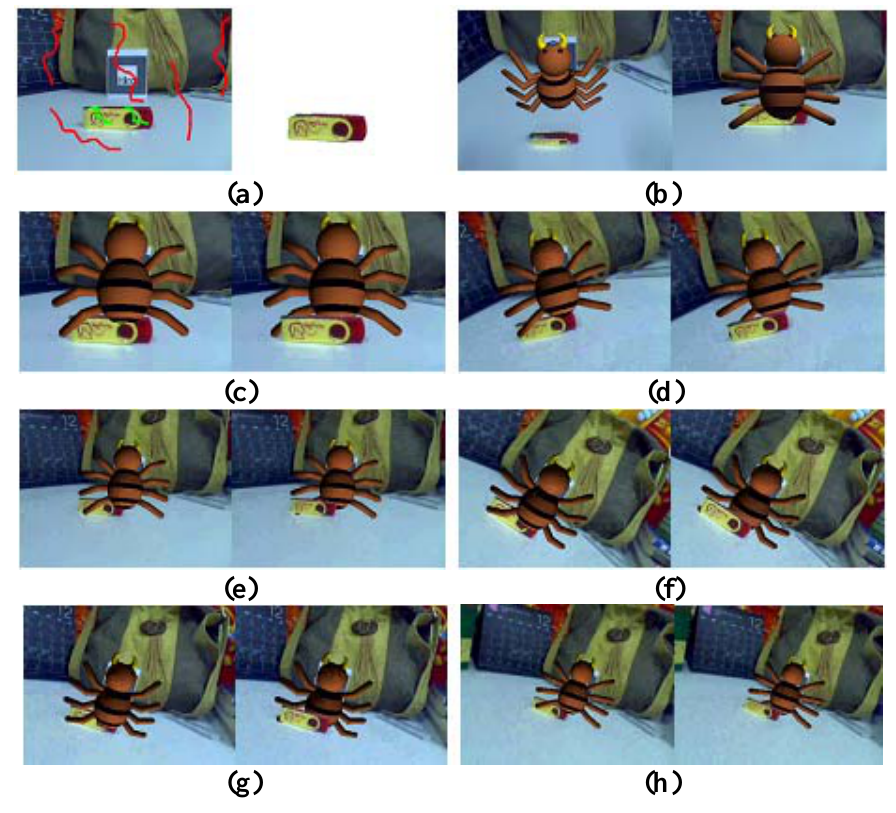
Figure 5. Results of the first experiment to test the proposed occlusion handling